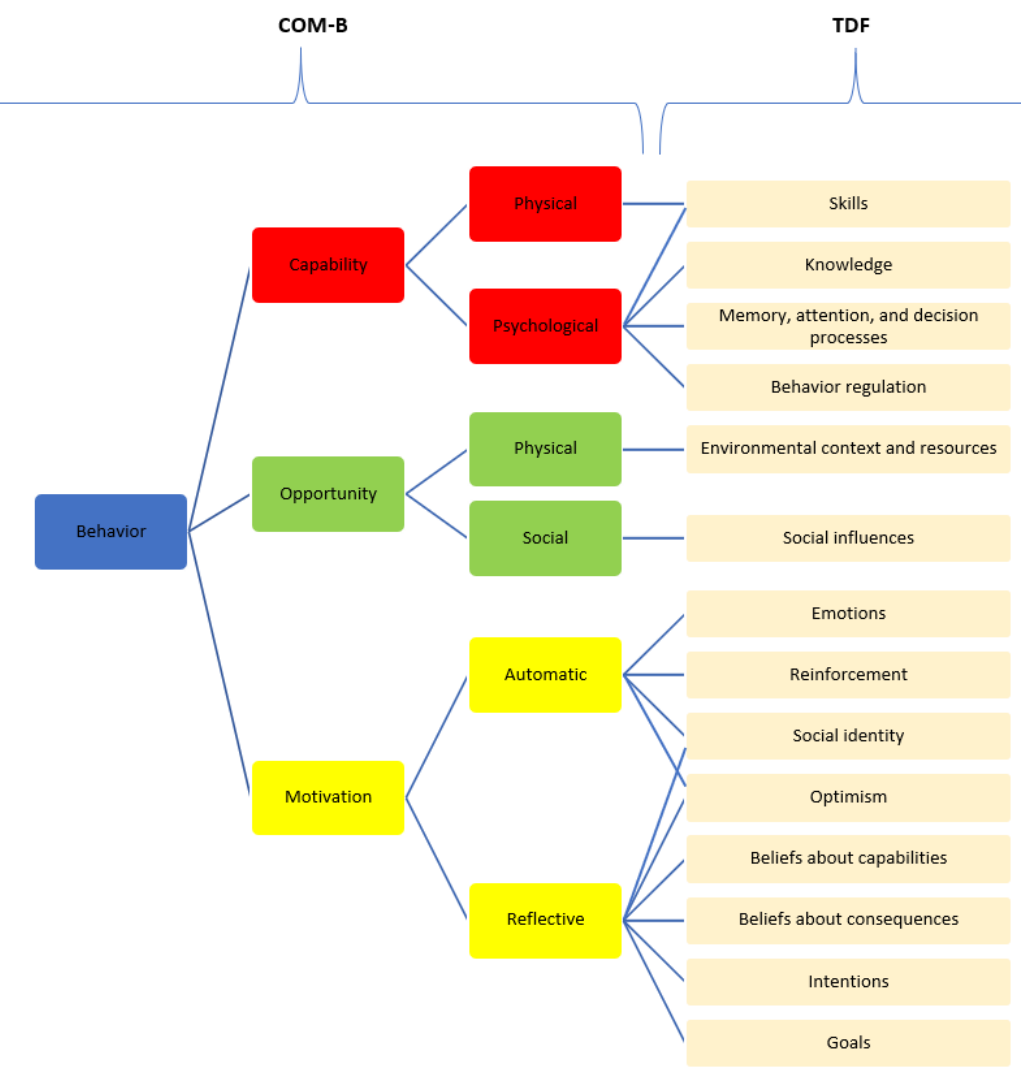
Figure 1. A visual representation of mapping the TDF onto the COM-B model. COM-B model: Capability, Opportunity, Motivation-Behavior model; TDF: Theoretical Domains